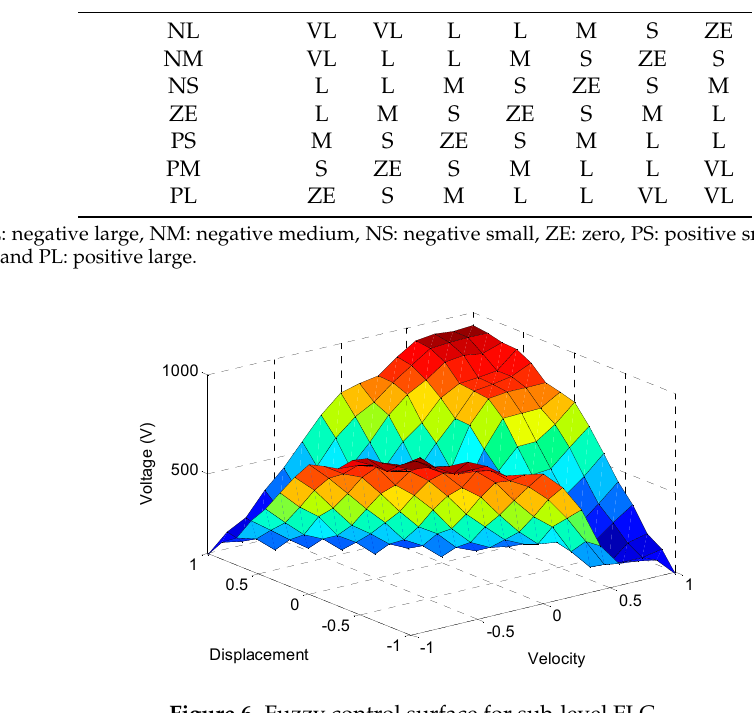
Figure 6. Fuzzy control surface for sub ‐ level FLC.